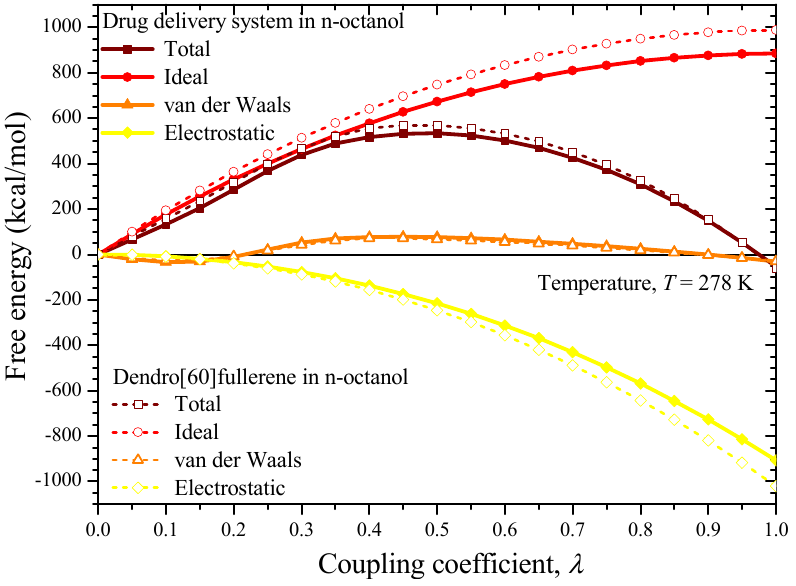
Figure 11. The free energies of the dendro[60]fullerene/molnupiravir drug delivery system and the dendro[60]fullerene in n-octanol versus the value of the coupling coefficient.